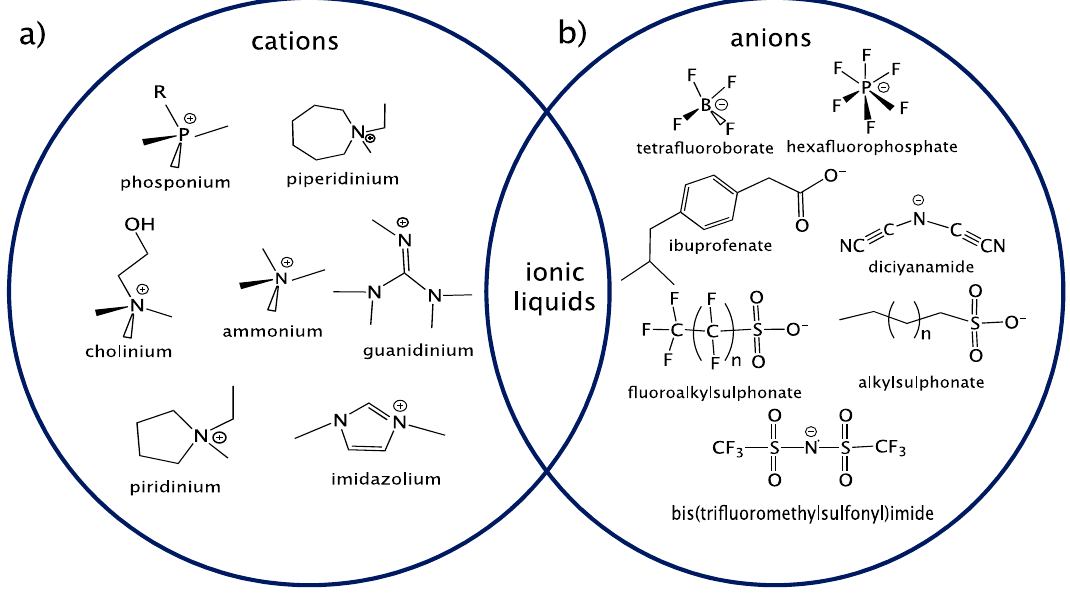
Figure 5. Representation of common classes of ( a ) cations and ( b ) anions, respectively, used as IL